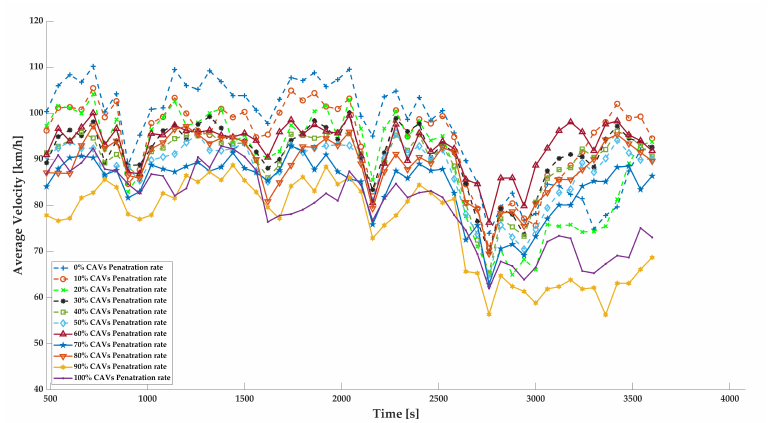
Figure 12. Average speed over the network for the various CAV penetration